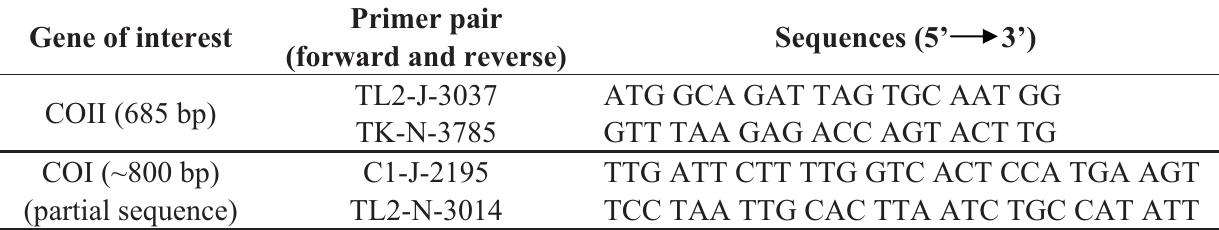
Table 3. Primer sequences used for amplification and gene